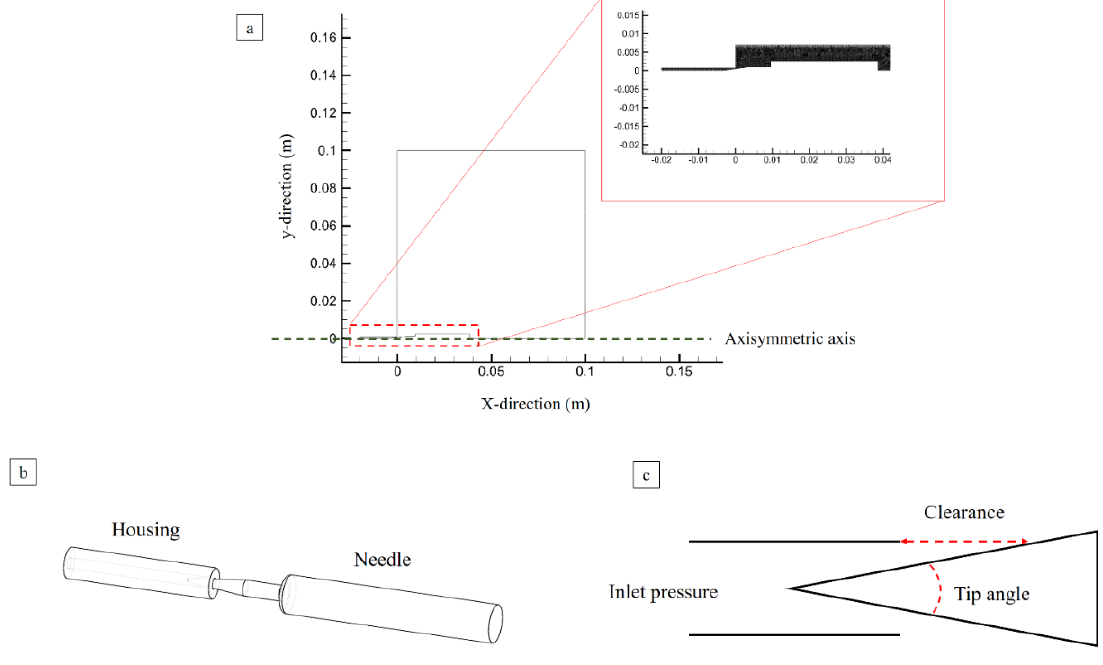
Figure 2. ( a ) Computational domain; ( b ) needle and housing configuration; and ( c ) needle draft